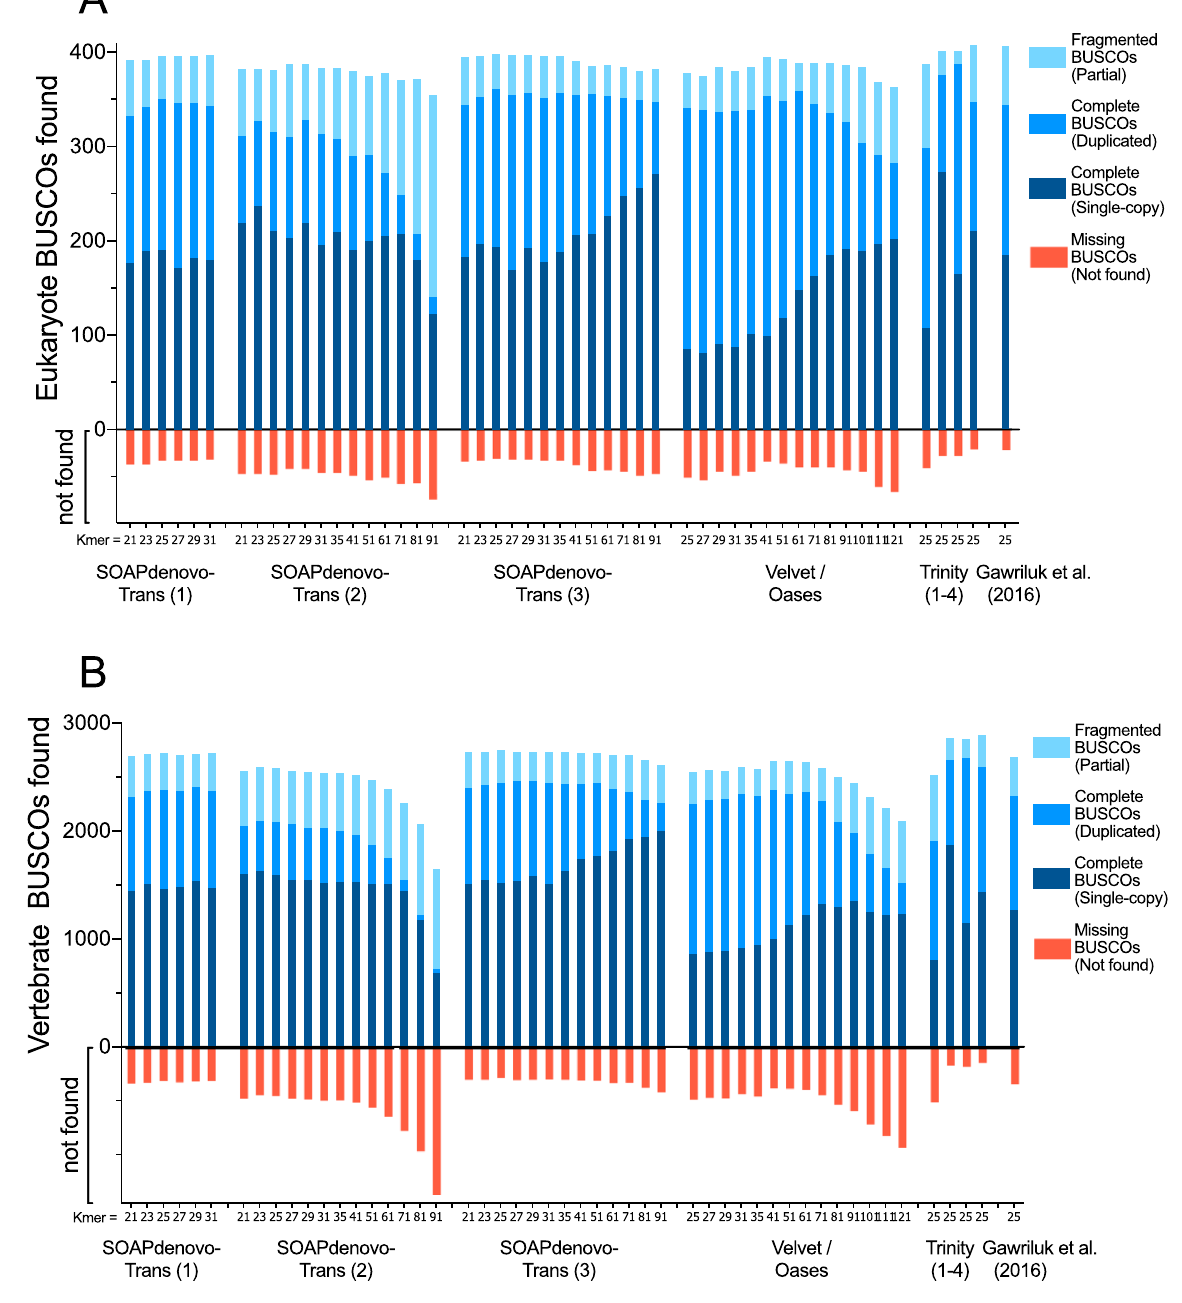
Figure 2. BUSCOs identified in each single-kmer transcriptome assembly. SOAPdenovo-Trans (1): reads prior to quality filtering; SOAPdenovo-Trans (2): light filtering of poor quality read pairs, combined with in silico normalization; SOAPdenovo-Trans (3): moderate filtering of poor quality read pairs; Velvet/Oases: moderate filtering of poor quality read pairs; Trinity (1): light filtering of poor quality read pairs, combined with in silico normalization; Trinity (2): light filtering of poor quality read pairs, combined with SEECER error correction; Trinity (3): moderate filtering of poor quality read pairs; Trinity (4): light filtering of poor quality read pairs, assembled with